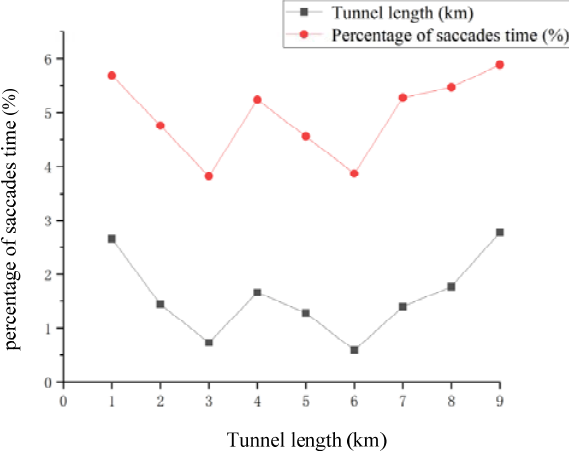
Figure 8. Experimental data of tunnel length and percentage of scanning time.